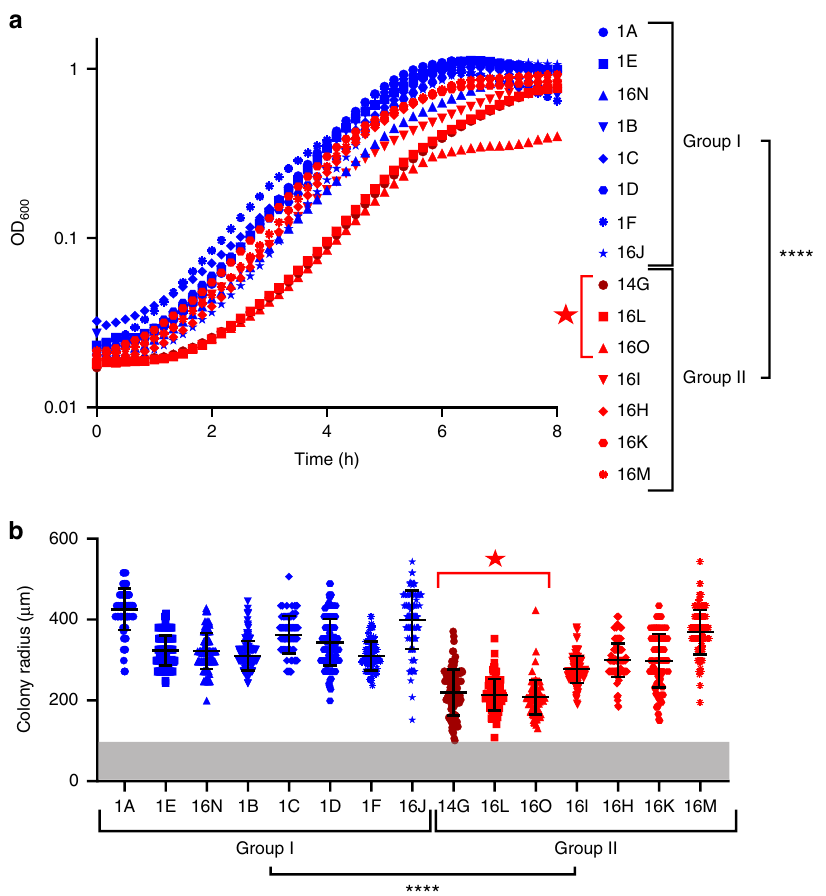
Fig. 4 Growth characteristics of ST378 isolates. a Growth curves of S. epidermidis isolates in the liquid TSB medium. The mean growth curve of three replicates is shown. Statistical signi fi cance of the time to reach OD 0.1 between the two groups was determined by Welch's t test ( N = 46 t (29.96) = − 5.0064, P = 2.295 × 10 -5 ). b Colony size for the different isolates after 24 h growth on sheep blood plates. Scatter dot plot with averages and standard deviations of 89 – 182 colonies per isolate are shown. The gray zone corresponds to a colony radius < 100 µ m, which was the detection limit of our setup. Statistical signi fi cance between the two groups was determined by Welch's t test ( N = 1947 t (1587.8) = − 19.634, P < 2 × 10 − 16 ). Group I and group II isolates are indicated in blue and red, respectively. Dark red indicates the clinical isolate retrieved from the blood culture. The red star refers to the monophyletic cluster formed by the three isolates with delayed growth curves and smallest colonies at 24 h. **** P <